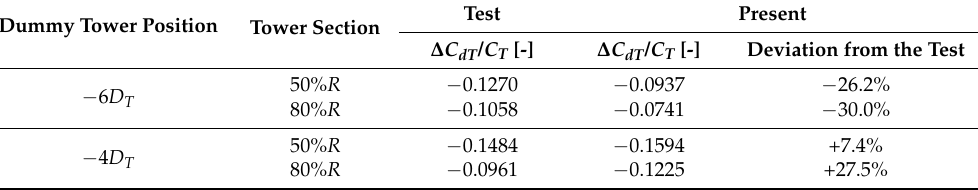
Figure 15. Relationship between tower drag and rotor thrust. Table 3. Fraction of the deviation of the tower drag coefficient to the thrust coefficient.